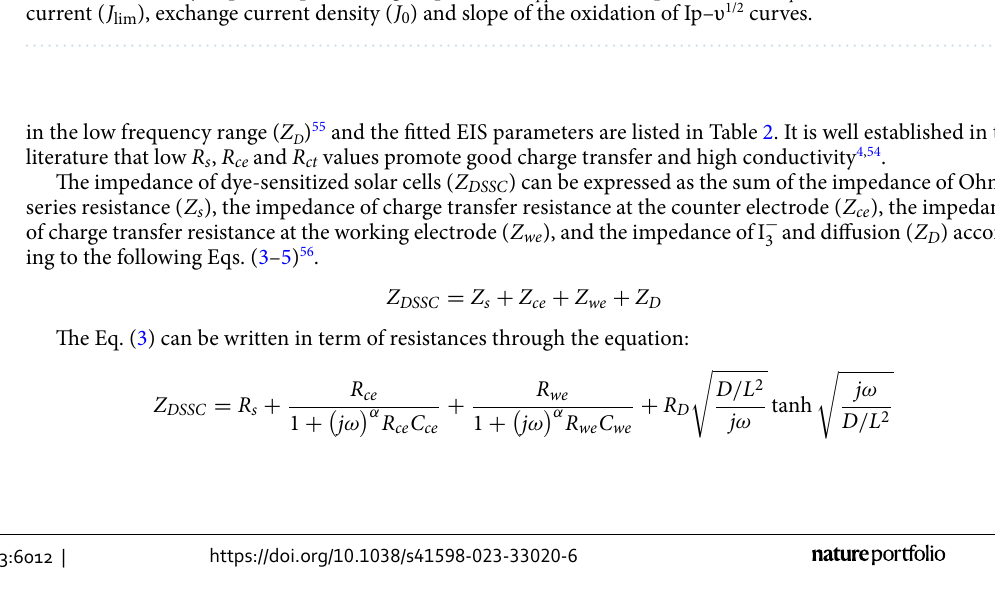
Table 1. Summary of peak to peak voltage separation ( E pp ), cathodic peak current ( J pc ), diffusion-limited current ( J lim ), exchange current density ( J 0 ) and slope of the oxidation of Ip–υ 1/2 curves.